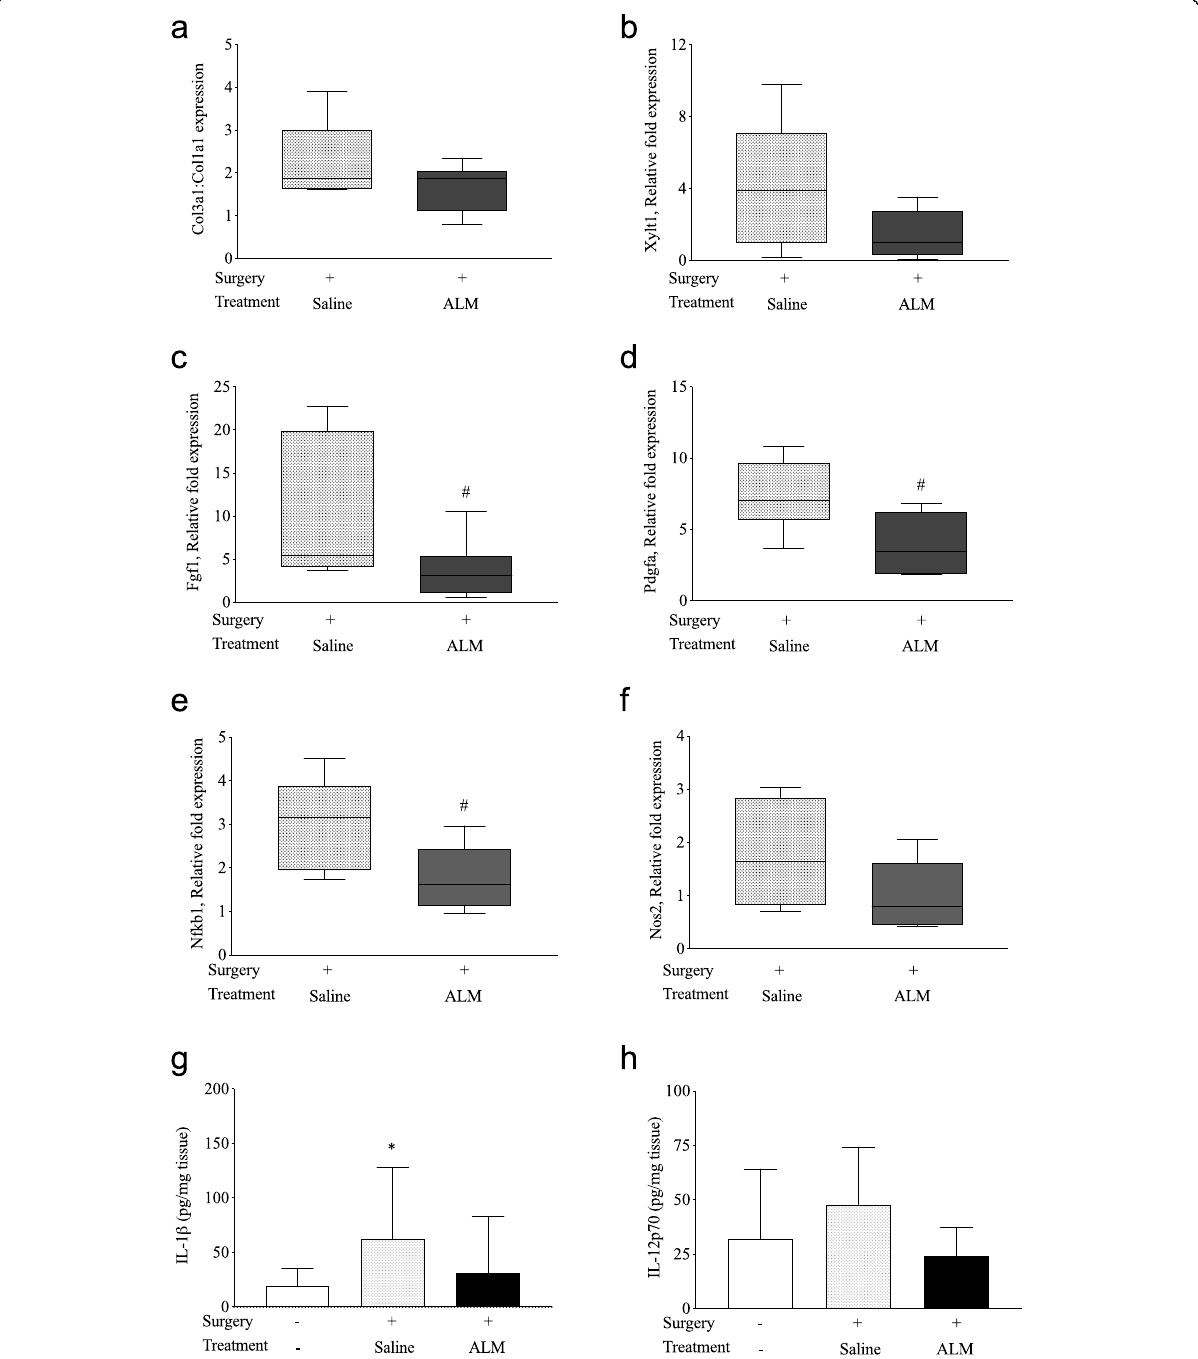
Fig. 4 Expression of key markers of ECM remodeling and inflammation in joint capsular tissue of ALM-treated and saline control animals, 4 weeks following knee implant surgery. mRNA expression of a Col3a1 : Col1a1 ratio, and b Xylt1 tended to be lower in capsular tissue from ALM-treated animals, compared to controls, though these differences were not statistically significant. Compared to controls, c Fgf1 , and d Pdgfa expression was significantly lower in joint tissue from ALM-treated animals. Compared to controls, mRNA expression of e NFkB1 and f NOS2 and protein expression of g IL-1 β , and h IL-12p70 was lower in the ALM treatment group. Data are expressed as mean ± SD. * P < 0.05, vs. baseline (no surgery, no treatment), # P < 0.05, compared to saline controls; n = 6 per